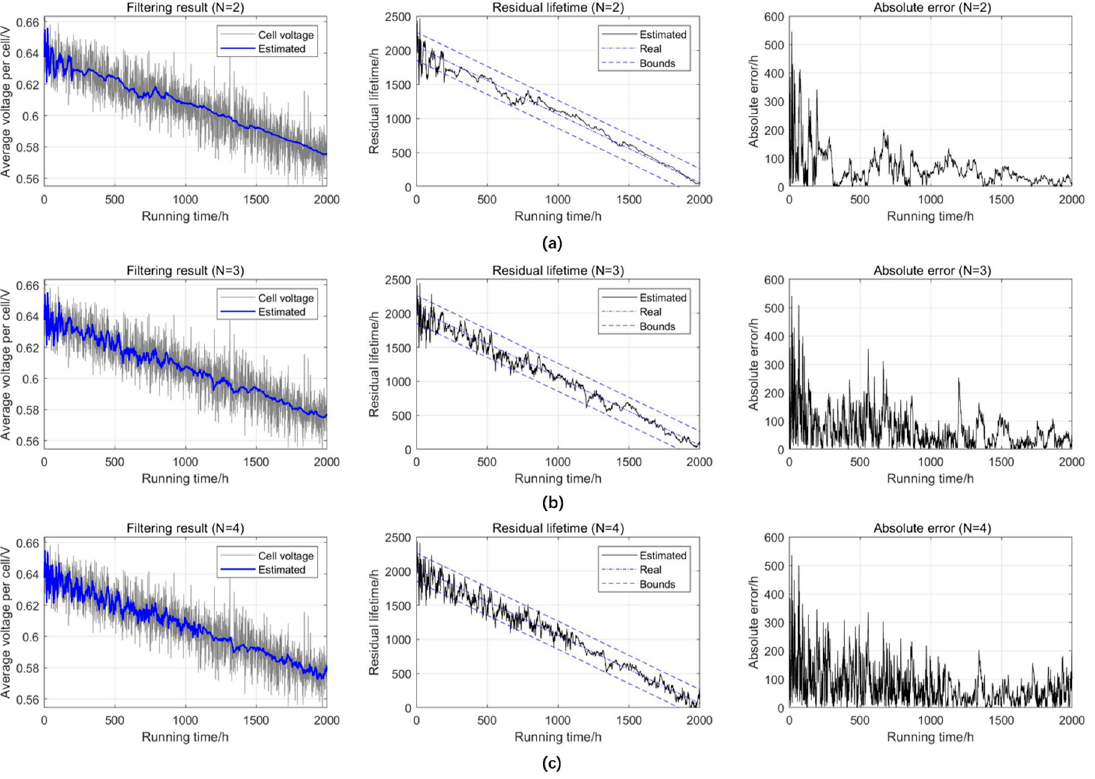
Figure 12. Influence of parameter N on prediction (( a ) N = 2; ( b ) N = 3; ( c ) N = 4).